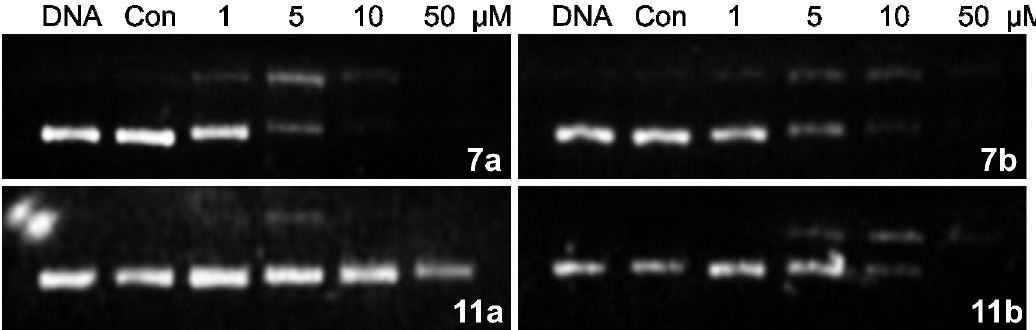
Figure 4. Agarose Gel Cross-Link